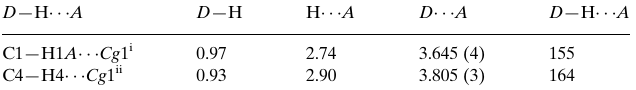
Hydrogen-bond geometry (A˚ , (cid:3) ). Cg 1 is the centroid of the C5–C10